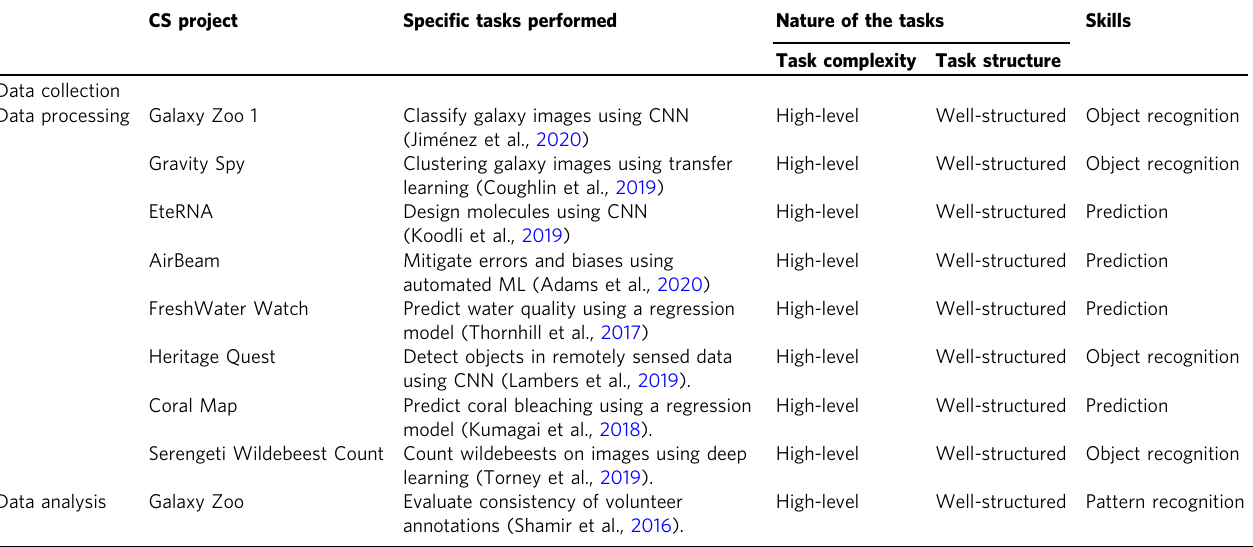
Table 7 Tasks performed by AI computational technologies and skills needed across the activities — examples from the